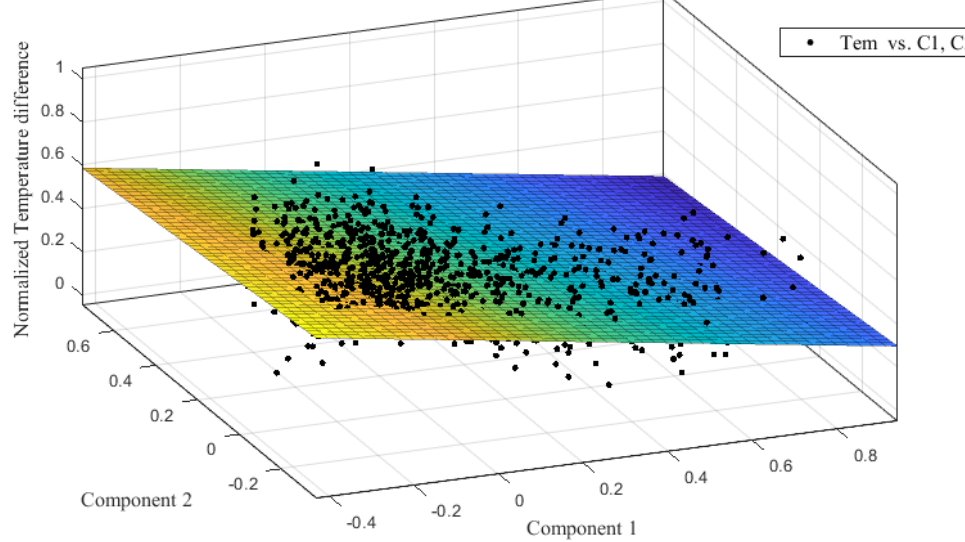
Figure 10. Multi-linear regression of the temperature difference and principle components 1 and 2.